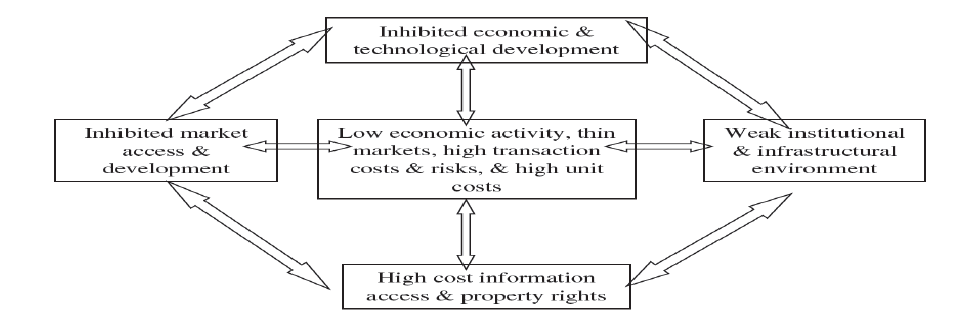
Fig. 1. Institutions and the low level equilibrium trap Source: from Dorward et al.